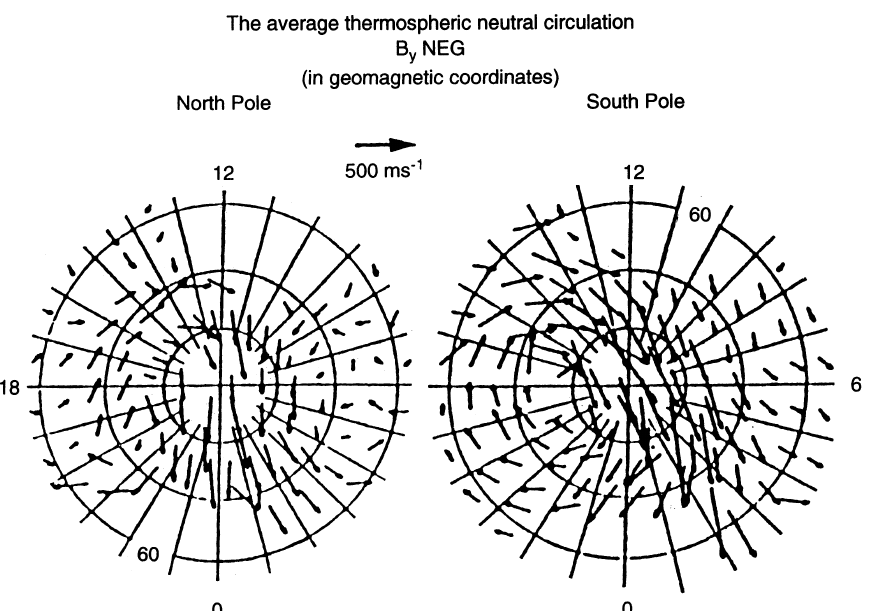
Fig. 10. The geomagnetic polar plots of the mean thermospheric circulation measured on the DE-2 satellite (Thayer et al ., 1987) between November and January in the years 1981–1982 in the northern ( left plot ) and Southern ( right plot ) Hemispheres for the IMF B